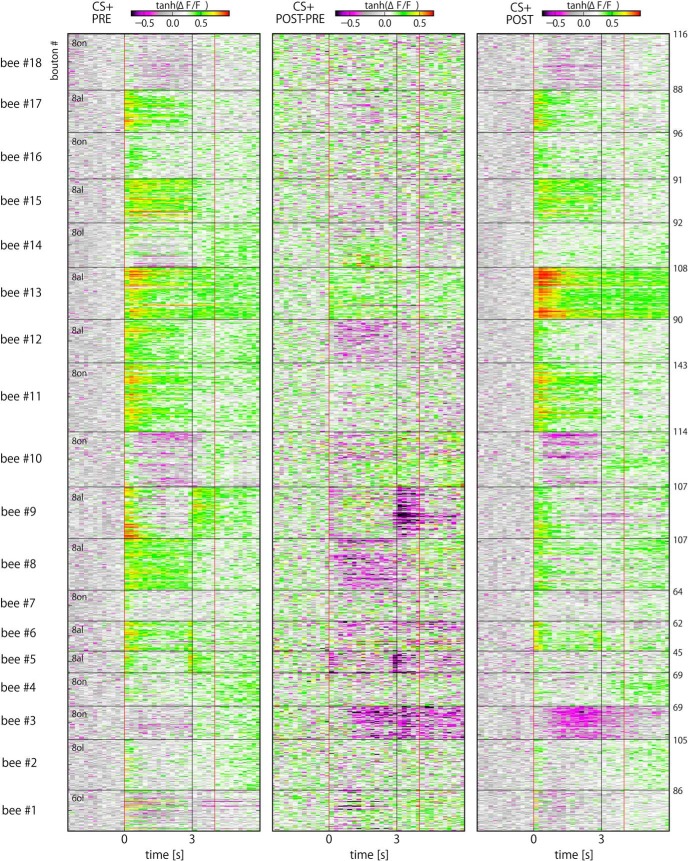
CS+ evoked responses in all recorded boutons. Color-coded CS+ odor responses of all 1652 PN boutons recorded from 18 bees. Ca2+ activity of individual boutons in PRE (left) and POST (right) phases as well as their differences (ΔNR, middle) are shown. Black horizontal lines separate boutons of different animals, whose IDs are given as ordinate labels. Odors were applied between 0 and 3 s. Measures of neural plasticity and SNRs were calculated on the basis of all time steps between 0 and 4 s (enclosed by red horizontal lines). 8ol: octanol, 6ol: hexanol.